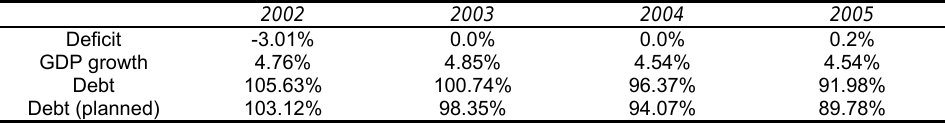
Table 8. Italian government deficit plan after a one-time deviation in